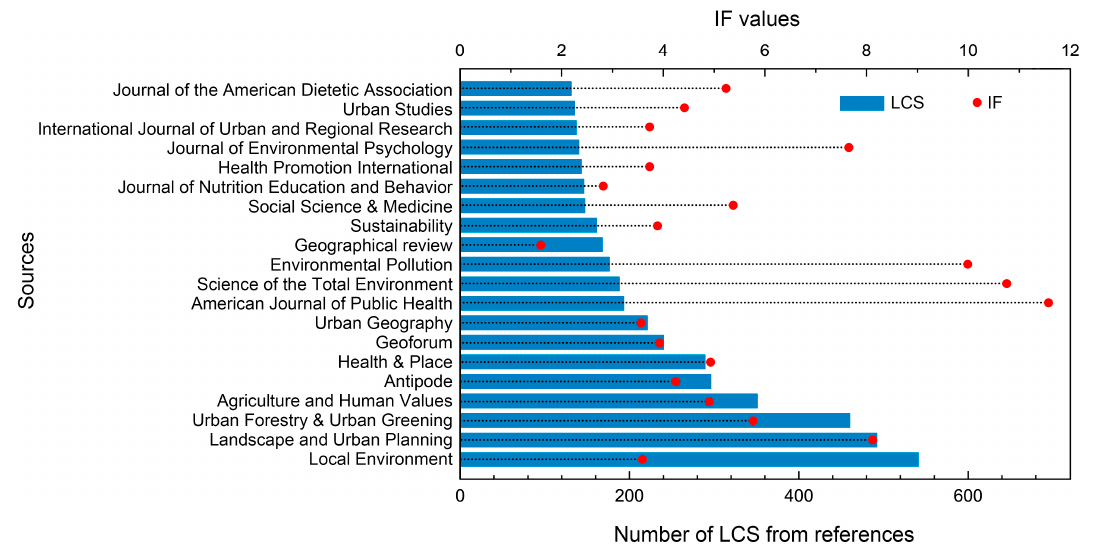
Figure 6. The top 20 local cited sources (LCS) on community gardens research from 1995 to 2022. The blue histogram represented the number of LCS (bottom X axis). IF is impact factor comes from 2021 Journal Citation Reports. The red dot was the impact factor of journals (upper X axis).